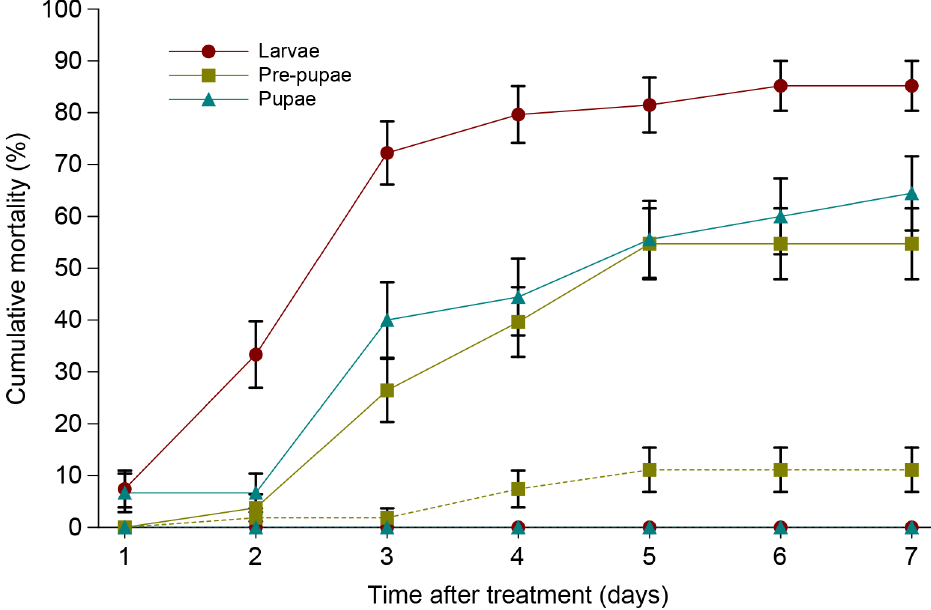
Fig 4. Cumulative mortality of last-instar larvae, pre-pupae and pupae of L . decemlineata treated by S . feltia e. Dashed lines indicate mortality in controls. Vertical bars indicate standard error.